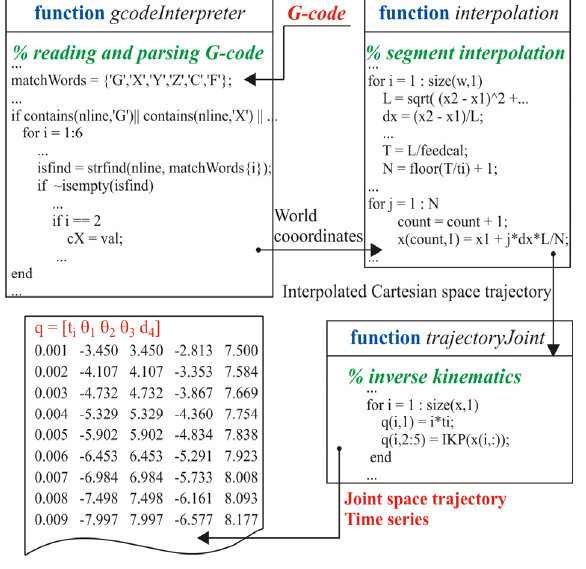
Figure 7. Generating the joint space trajectory After the linear interpolation of trajectory in Cartesian space, the function trajectory Joint involving the inverse kinematic solution, equations (9), (14), and (15), generates the joint space trajectory with an added vector of interpolated time as the first column. The result presents the time-series of joint coordinates necessary for the simulation of generated Simscape virtual robot.